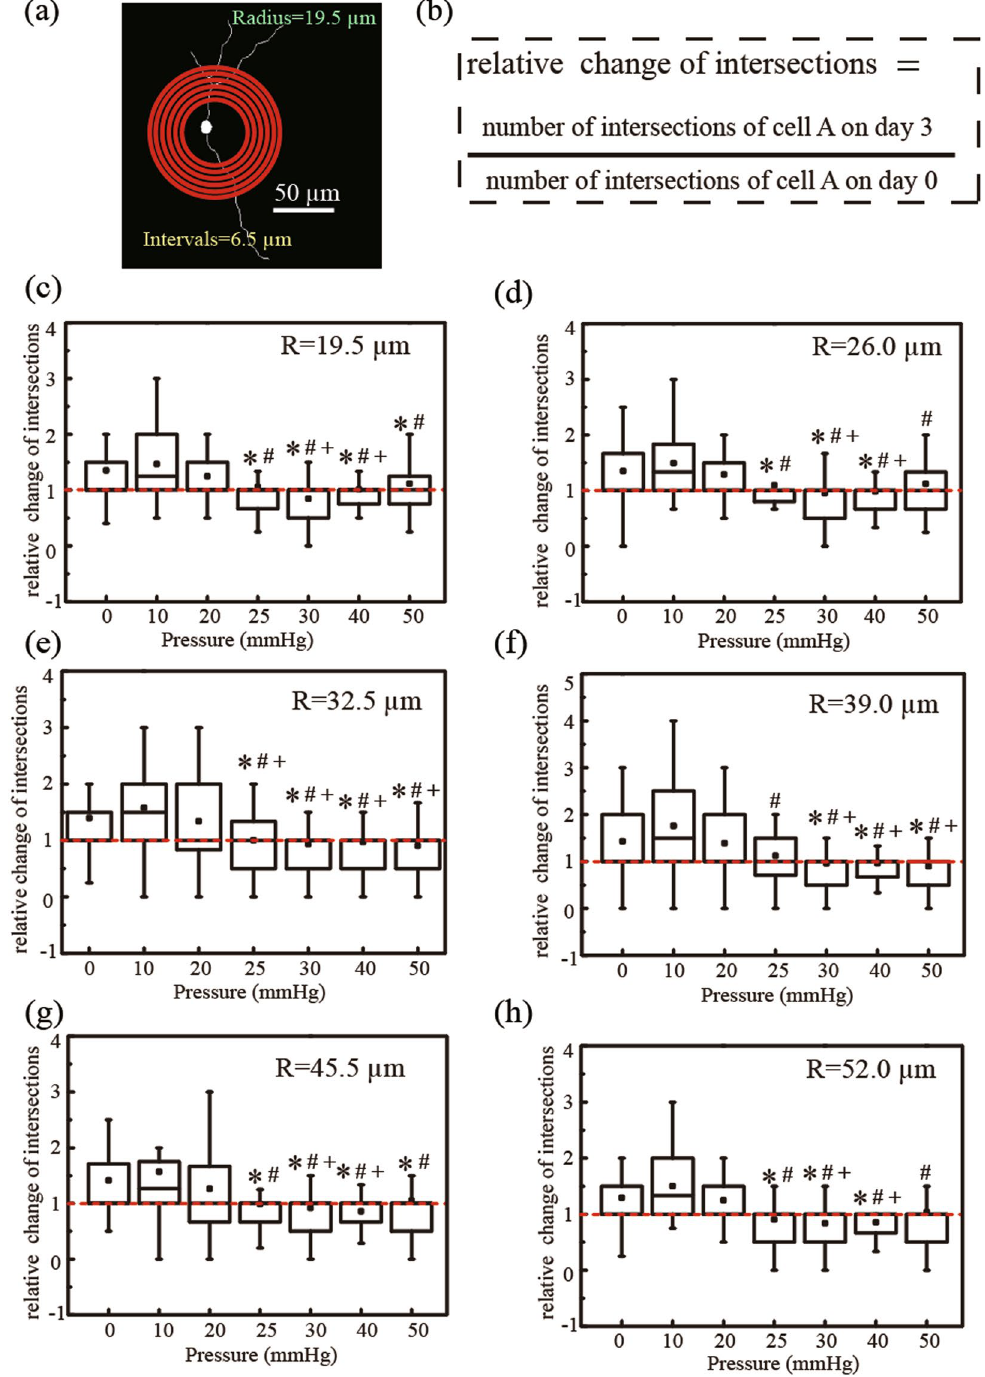
Figure 7. ( a ) Sholl analysis of primary RGCs, ( c – h ) Box chart of the relative number of intersections between neurites and concentric circles(R = 19.5 µ m, 26.0 µ m, 32.5 µ m, 39.0 µ m, 45.5 µ m and 52.0 µ m)after applied hydrostatic pressures of 0 mmHg (n = 155 RGCs), 10 mmHg (n = 67 RGCs), 20 mmHg (n = 109 RGCs), 25 mmHg (n = 77 RGCs), 30 mmHg (n = 76 RGCs), 40 mmHg (n = 80 RGCs), and 50 mmHg (n = 74 RGCs) on day 3. Box plot whiskers indicate the maximum and minimum values of the data. The symbols * , # and + indicate statistical significance relative to 0 mmHg (P < 0.05), 10 mmHg (P < 0.05), and 20 mmHg (P < 0.05), respectively, using One-way ANOVA followed by Bonferroni Post-hoc